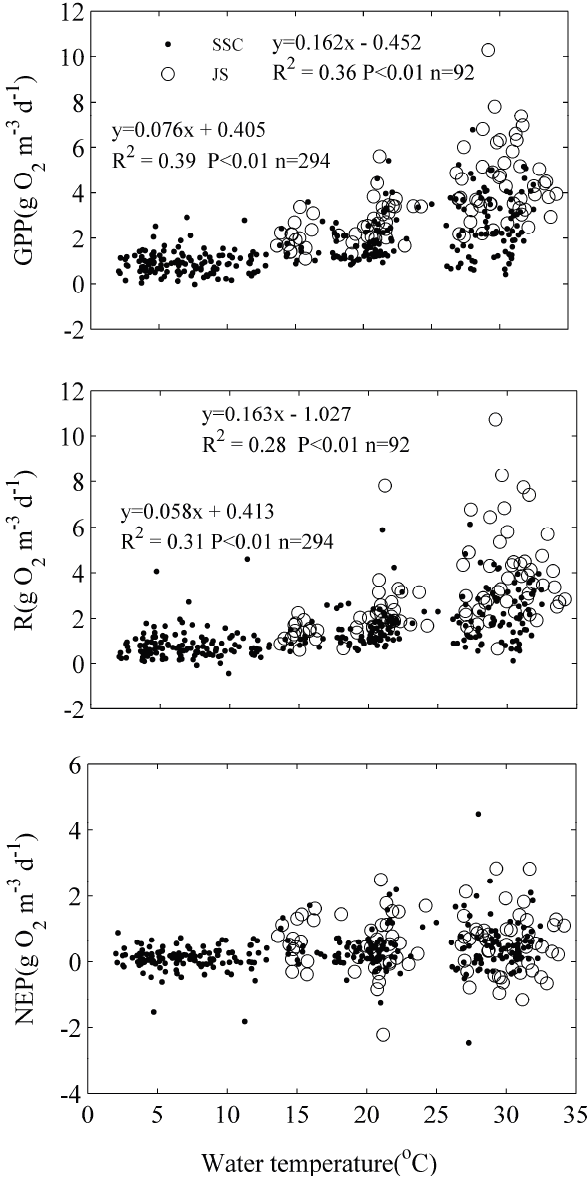
Figure 7. Relationships between daily values of gross primary production (GPP), ecosystem respiration (R), net ecosystem production (NEP), daily average values of water temperature, and surface